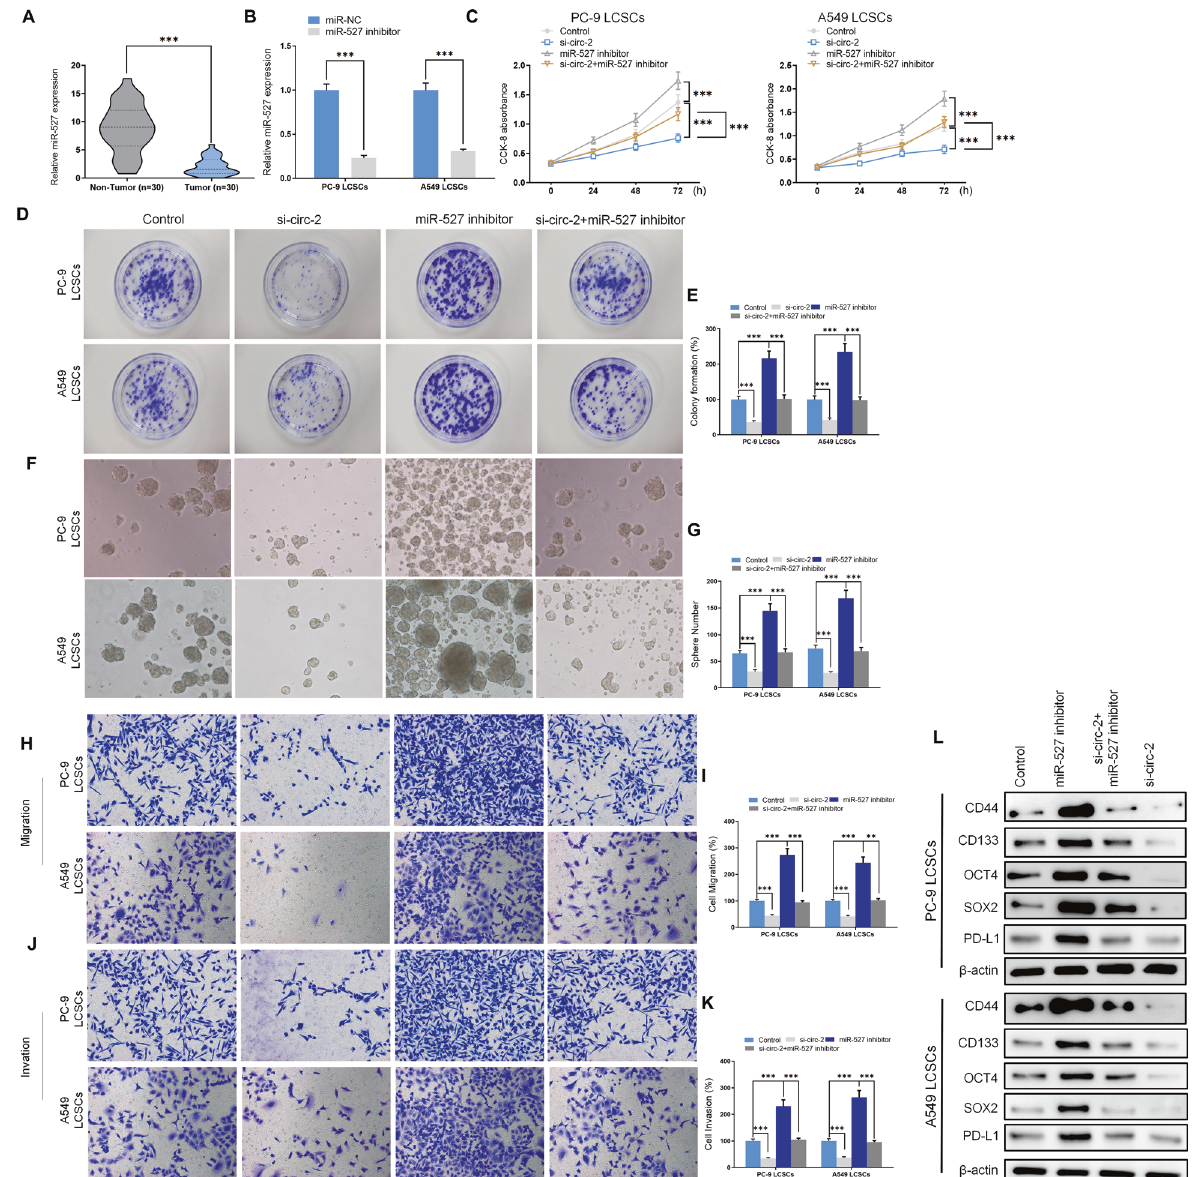
Fig. 4 Inhibition of miR-527 reversed the block effectiveness of hsa_circ_0001421 suppression on NSCLC cell proliferation and stemness in vitro. A RT-qPCR demonstrating miR-527 level from 30 NSCLC tumor tissues and adjacent non-tumor tissues. B RT-qPCR demonstrating miR-527 level in LCSCs. C CCK8 assays presented cell proliferation at different time points. D , E Colony formation presented proliferation in LCSCs. F , G Spheroid formation was assessed in PC9 and A549 lung cancer stem cells (LCSCs). H – K Transwell assays presented cells migration and invasion. L Western blot demonstrating CD44, CD133, OCT4, SOX2, and PD-L1 levels in PC9 and A549 LCSCs. Data were shown as mean ± SD; ** P < 0.01, *** P <